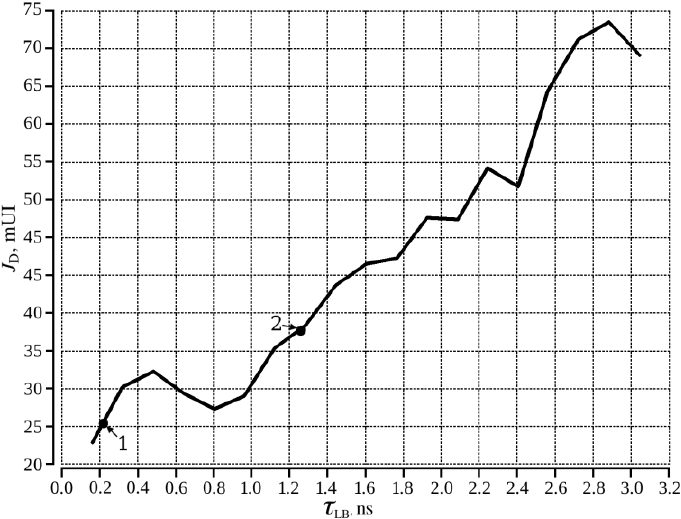
Fig. 2. The dependency of J D on τ LB value: 1 – the point corresponding to τ LB for the reference model; 2 – the point where the deviation of J D value from the reference value exceeds